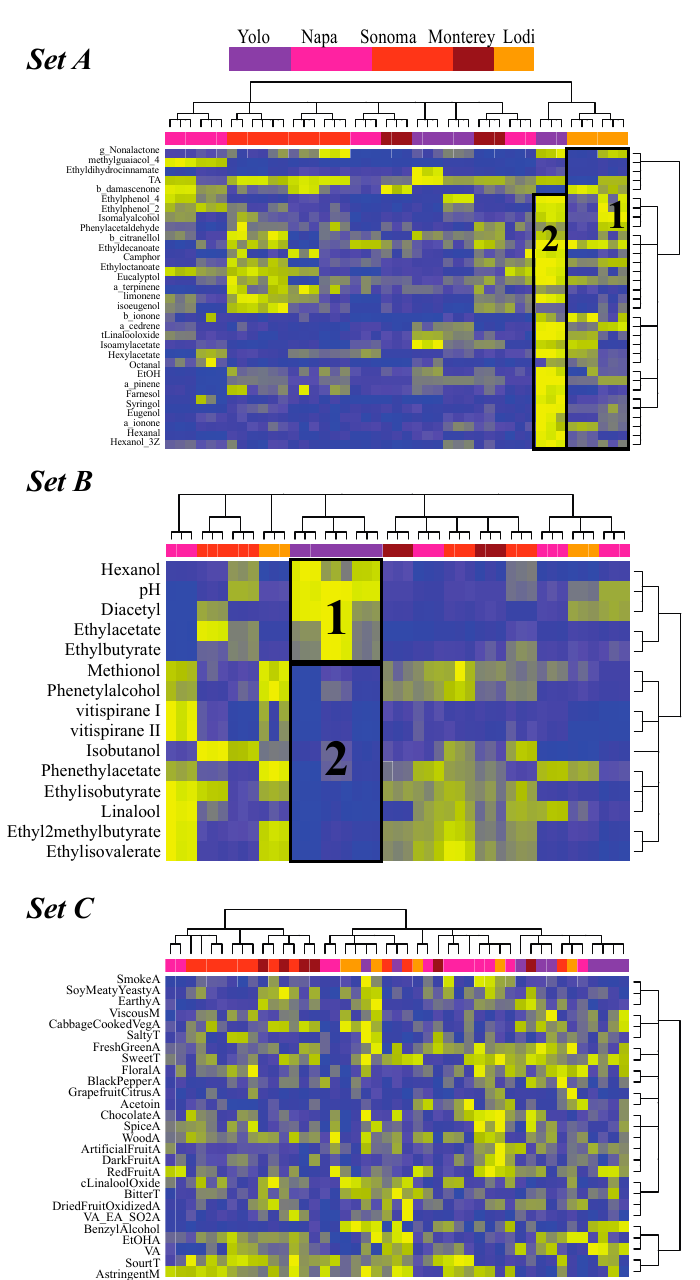
Figure 4. Clustering the Californian wines. The 45 wines are clustered using Data Mechanics on the three di ff erent sets of wine characteristics, ( A — C ) that are defined in ( A ). The corresponding heat maps have wines as rows, and wine characteristics as columns. The color scale blue to yellow used to represent the heat maps corresponds to the interval [1,10] for the digital scores (see text for details on those digital score, with blue mapping to 1 and yellow to